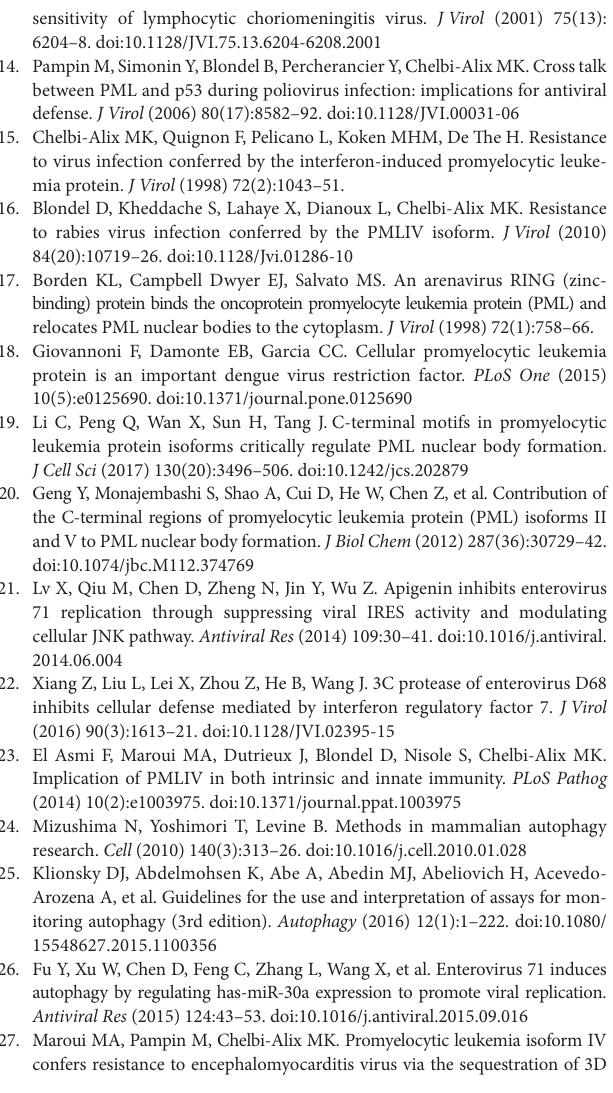
were transfected with si-ATG5 or negative siRNA (siNC) and then with GLuc-EV71 at an MOI of 5 for 48 h. The cells were harvested, and the cell lysates were analyzed by performing a Western blot analysis using antibodies against ATG5, LC-3B, VP1, and GAPDH. The density of the bands was scanned by densitometry and expressed relative to that of the siNC-treated and mock-infected cells. The siNC-treated and mock-infected cells were assigned a value of 1.00. *** p < 0.005, ** p < 0.01. FigUre s4 | Effect of the proteasome inhibitor epoxomicin on the degradation of PMLIII and IV. HeLa cells were transfected with the control plasmid EGFP-C1 or increasing amounts of GFP-3C. At 24 h post transfection, the cells were treated with epoxomicin (1 μ M) for 24 h. Then, the cell lysates were processed for a Western blot analysis. The density of the bands was scanned by performing densitometry and expressed relative to the control (pEGFP-C1), which was assigned a value of 1.00. *** p < 0.005. FigUre s5 | PML − / − HeLa cells were transfected with plasmids expressing individual FLAG-PML isoforms for 24 h. Cells expressing each individual PML isoform were transfected with an empty control pEGFP-C1 or pEGFP-3C for 24 h. The cell lysates were analyzed by performing a Western blot analysis using antibodies specific for FLAG, GFP, and GAPDH. Each experiment was performed three times, and representative results are